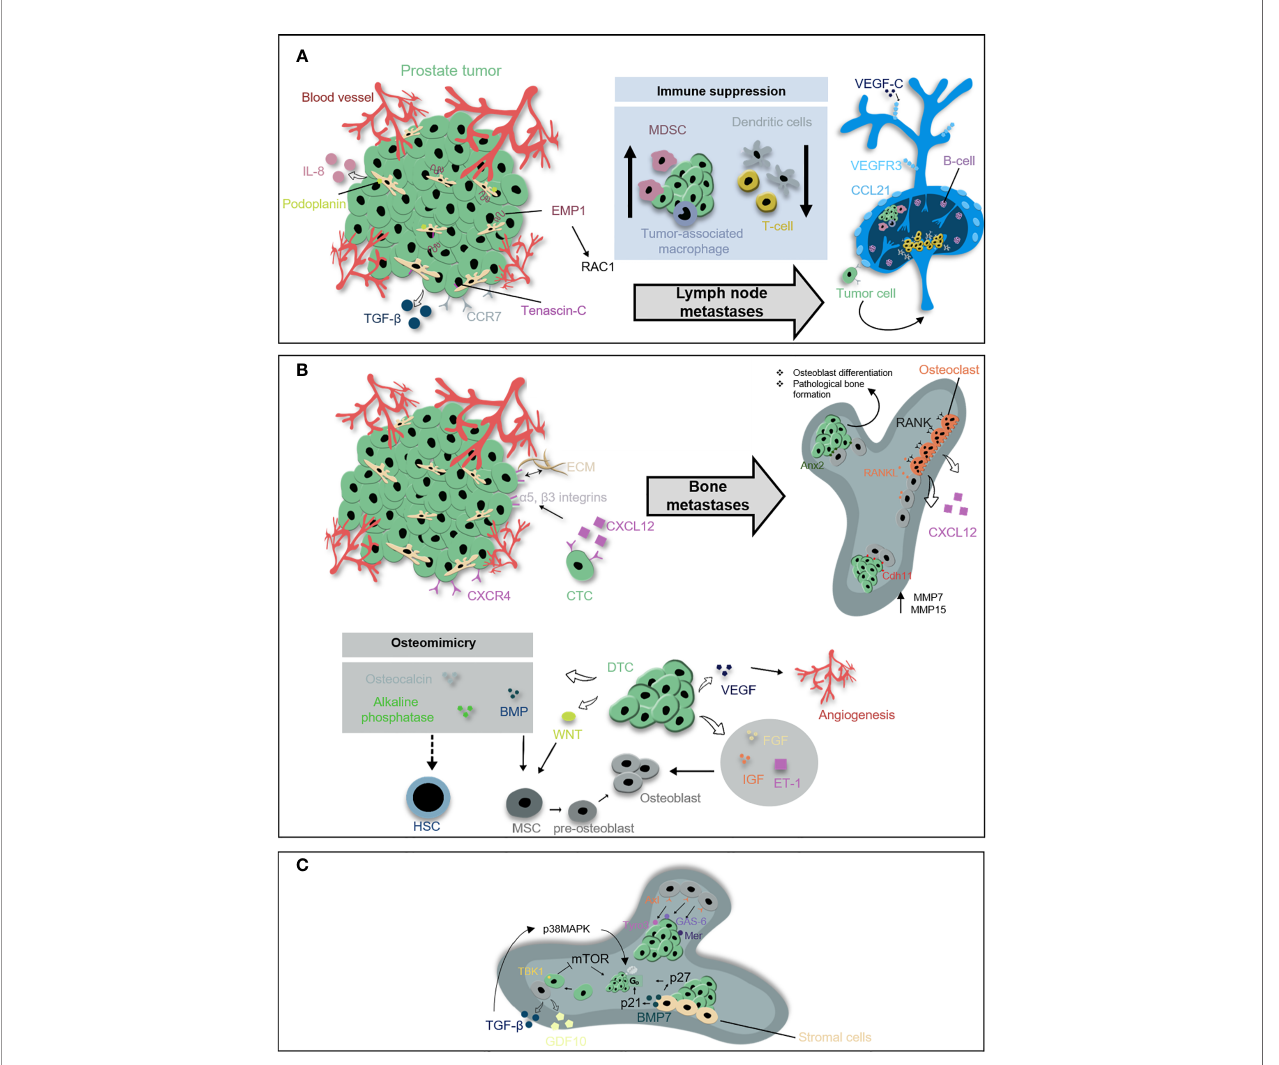
FIGURE 2 | Prostate metastases within lymph nodes and bone. (A) Prostate cancer cells form a pre-metastatic niche in lymph nodes prior dissemination and colonization to the lymph nodes. The decreased immune function is re fl ected by the reduced density of dendritic cells and T cells but also by the attraction of myeloid- derived suppressor cells (MDSCs) or tumor-associated macrophages. PCa cells and surrounded cancer-associated fi broblasts release soluble factors such as tumor necrosis factor a (TNF- a ), CC-chemokine ligand 21 (CCL21), and interleukin-8 (IL-8) involved in pre-metastatic niche formation within lymph nodes. CCL21 induces chemokine receptor 7 (CCR7) on PCa cells. Epithelial membrane protein 1 (EMP1) is induced in PCa cells after contact with prostate stromal cells and likely promotes metastasis into the lymph nodes via a Rac1-dependent mechanism. Lymph-angiogenesis involves the outgrowth and remodeling of lymphatic vessels and is induced by vascular endothelial growth factor C (VEGF-C) secreted from PCa cells and vascular endothelial growth factor receptor 3 (VEGFR3) on lymphatic vessels. (B) Beside lymph nodes, the bone is a major metastatic site for PCa. The C-X-C motif chemokine ligand 12 C-X-C chemokine receptor type 4 (CXCL12-CXCR4) signaling guides disseminating PCa cells into the bone where they colonize within already formed pre-metastatic endosteal niche close to osteoblasts. CXCL12/CXCR4 binding enhances the expression of a 5 and b 3 integrins in PCa cells and reinforces their adhesion to the extracellular matrix (ECM). Prostate disseminated tumor cells (DTCs) target the endosteal niches and compete with hematopoietic stem cells (HSCs) in order to survive. In the niche, DTCs release factors originally involved in bone formation and maintenance, such as osteocalcin, alkaline phosphatase, and bone morphogenetic proteins (BMP). DTCs support osteoblastic activity through the release of fi broblast growth factors (FGFs), insulin-like growth factors (IGFs), VEGFs, endothelin 1 (ET-1), Wnt pathway-related factors, and BMPs. Moreover, adhesion proteins facilitate the metastatic spread to the bone, including cadherin-11 (Cdh11) upregulating metalloproteinases MMP-7 and MMP-15. Osteoblasts redirect prostate cancer cells toward the endosteal niche by expressing Annexin2 (Anx2). PCa cells and other cells within the bone microenvironment subsequently are co-regulated throughout a vicious cycle e.g., via receptor activator of nuclear factor kappa-B ligand (RANKL). (C) Tumor cells within a quiescent phase, also known as dormancy, exhibit a reversible cell cycle arrest in G0 phase. Stroma-derived growth arrest-speci fi c protein 6 (GAS-6) induces dormancy by binding the Tyro3, Axl, and Mer receptor tyrosine kinases. Dormancy is also regulated by the expression of TANK-binding kinase 1 (TBK1) induced by osteoblast and PCa cell interactions inhibit mTOR signaling and induce G0 phase. Stroma- derived BMP-7 suppress the proliferation of PCa cells through increased expression of the mitotic inhibitors p21 and p27. Additional regulators of dormancy are GDF10 and TGF- b which phosphorylates